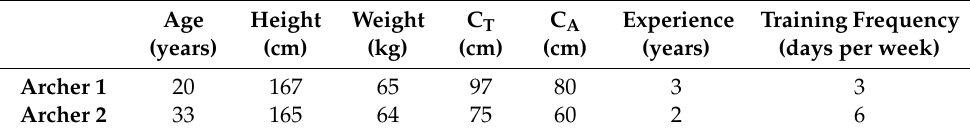
Table 4. Archers’ characteristics.